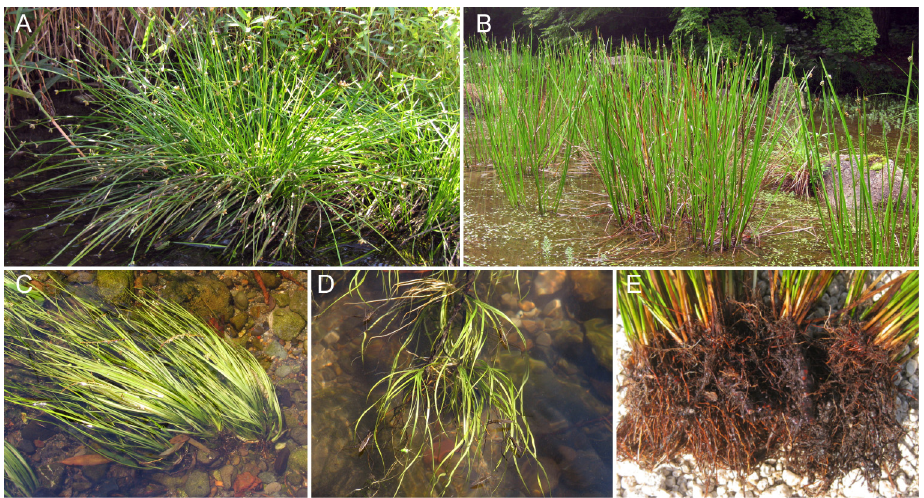
Fig 1. Morphologies of S . gemmifer and the closely related S . triangulates . (A) Gross morphology of S . gemmifer . Almost all large individuals become standing forms with flowers. (B) Gross morphology of S . triangulates . (C) A stream form of S . gemmifer with linear leaves. Almost all small individuals become stream forms. (D) The morphology of the settled gemmae of S . gemmifer . (E) The root system of a large individual that consists of several clumps of